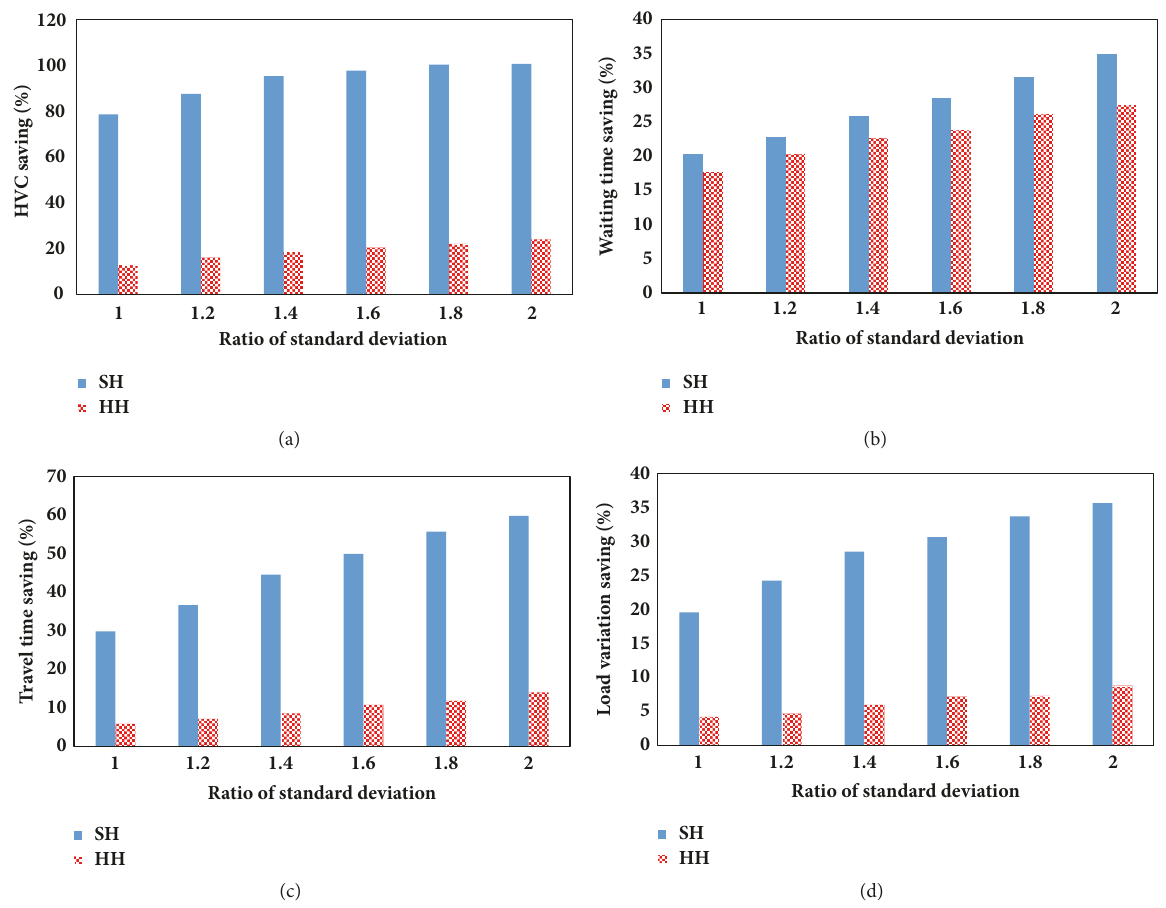
Figure 4: Percentage reductions in (a) HVC; (b) 𝐸(𝑤) ; (c) average travel time; (d) load variation under different travel time variation